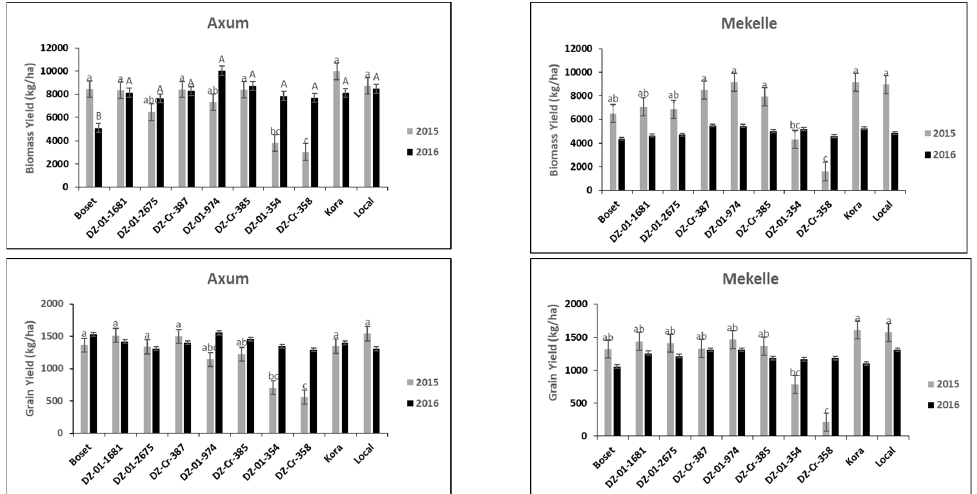
Figure 3. Differences of teff varieties in biomass and grain yields in Axum and Mekelle in 2015 and 2016. Means of the teff varieties were compared separately within each location and year considering the main effect of variety. Means with the same letter are not significantly different.